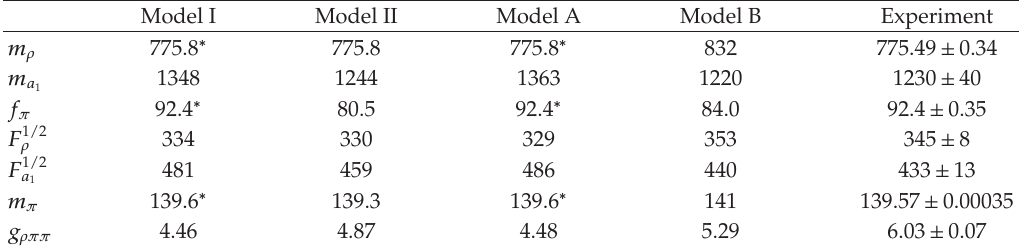
Table 1: Meson spectroscopy from the hard-wall model and from its variations: Model I (cid:4) 60 (cid:5) , Model II (cid:4) 43 (cid:5) , Model A (cid:4) 23 (cid:5) , and Model B (cid:4) 23 (cid:5) . The experimental data listed in the last column are taken from the particle data group (cid:4) 62 (cid:5) . All results are given in units of MeV except for the condensate and the ratio of two condensates. Model I Model II Model A Model B